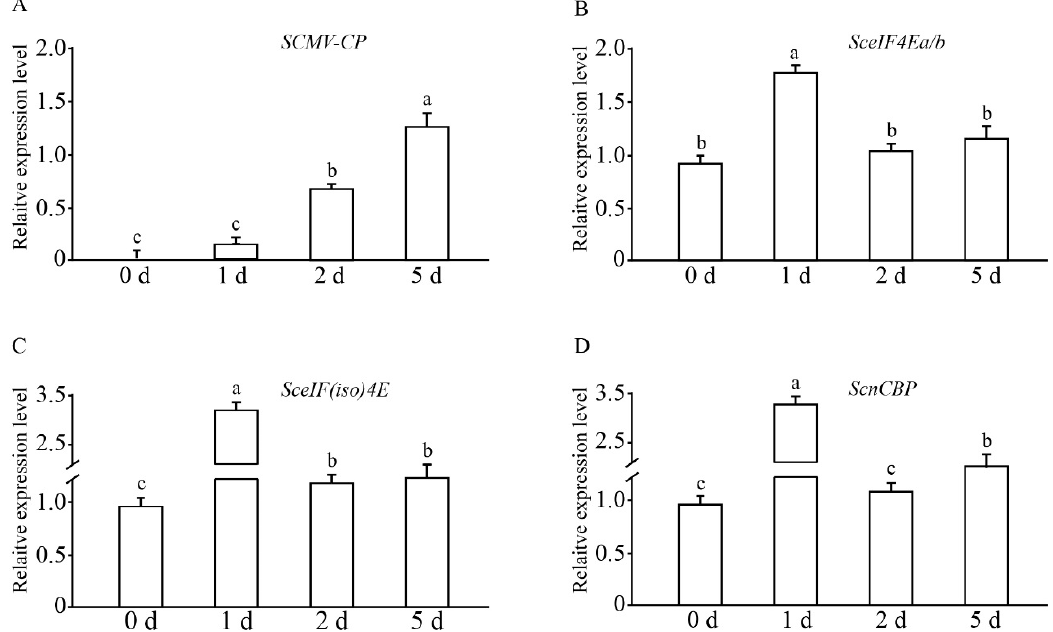
Figure 3. The expression profiles of SceIF4Ea/b , SceIF(iso)4E, and ScnCBP of sugarcane cultivar ROC22 challenged by Sugarcane mosaic virus (SCMV). Leaves of ROC22 plantlets were inoculated with SCMV and sampled at different time points. Mock inoculated plants with 0.01 M phosphate buffer (pH 7.0) were used as the negative controls. The Y axes indicates the relative expression of SCMV-CP ( A ), SceIF4Ea/b ( B ), SceIF(iso)4E ( C ), and ScnCBP ( D ) at 0, 1, 2, and 5 days post-inoculation. The X axes indicates the time point of material collection. Error bars indicate SD ( n = 3), a, b, and c indicate significance at the corresponding time points, t -test, p <0.05. Results were representative of three independent experiments.